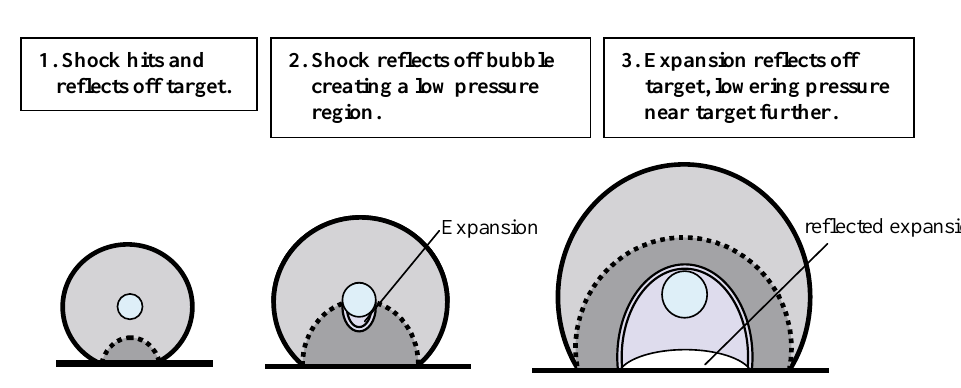
Fig. 2. Close-in fluid-structure interaction for a rigid target.